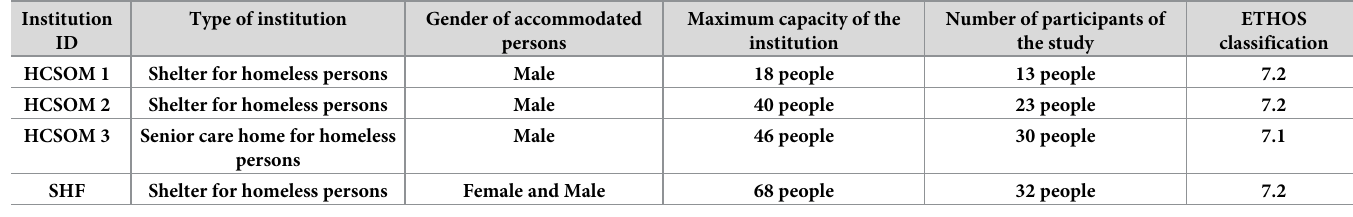
Table 1. The main characteristics of the participating